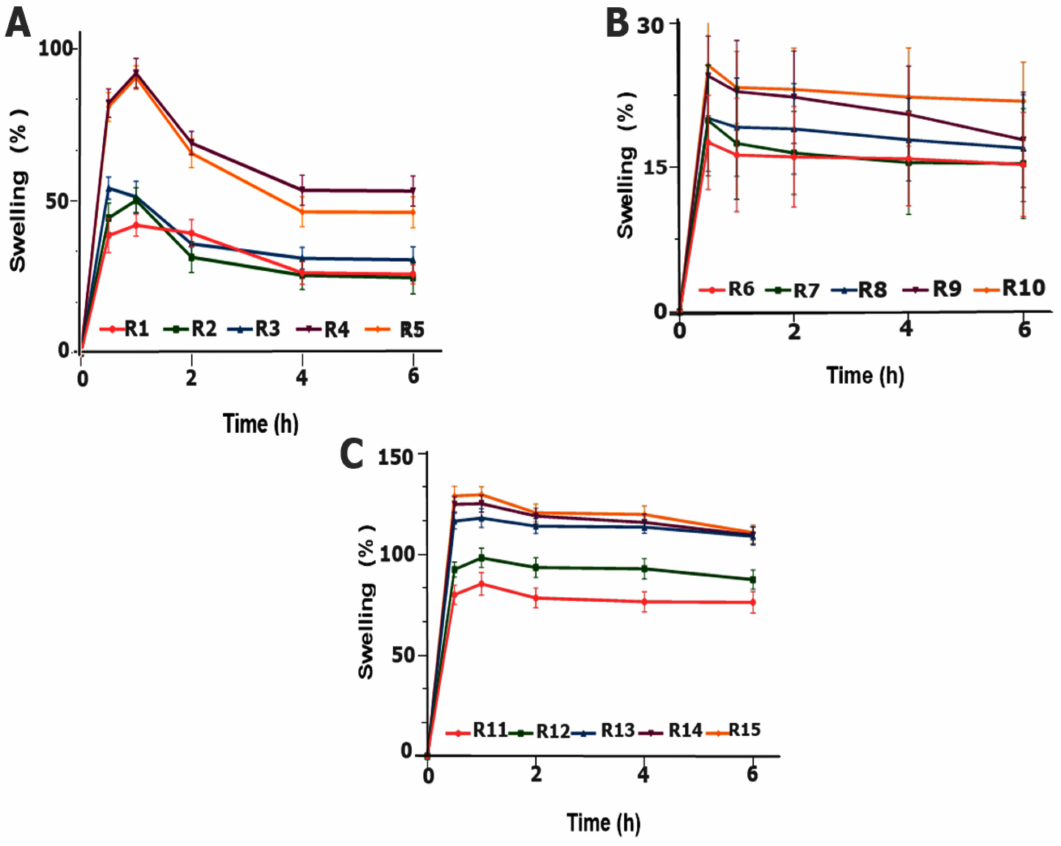
Figure 4. Swelling index of the formulations: ( A ) R1–R5, ( B ) R6–R10 and ( C )